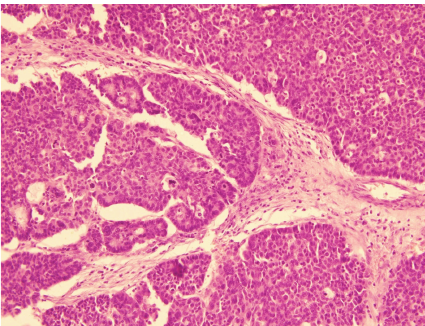
Figure 1: Section from the ovarian tumor showing nests of cells, focally arranged in a trabecular pattern, with prominent nuclear palisading (H and E stain, 10X).